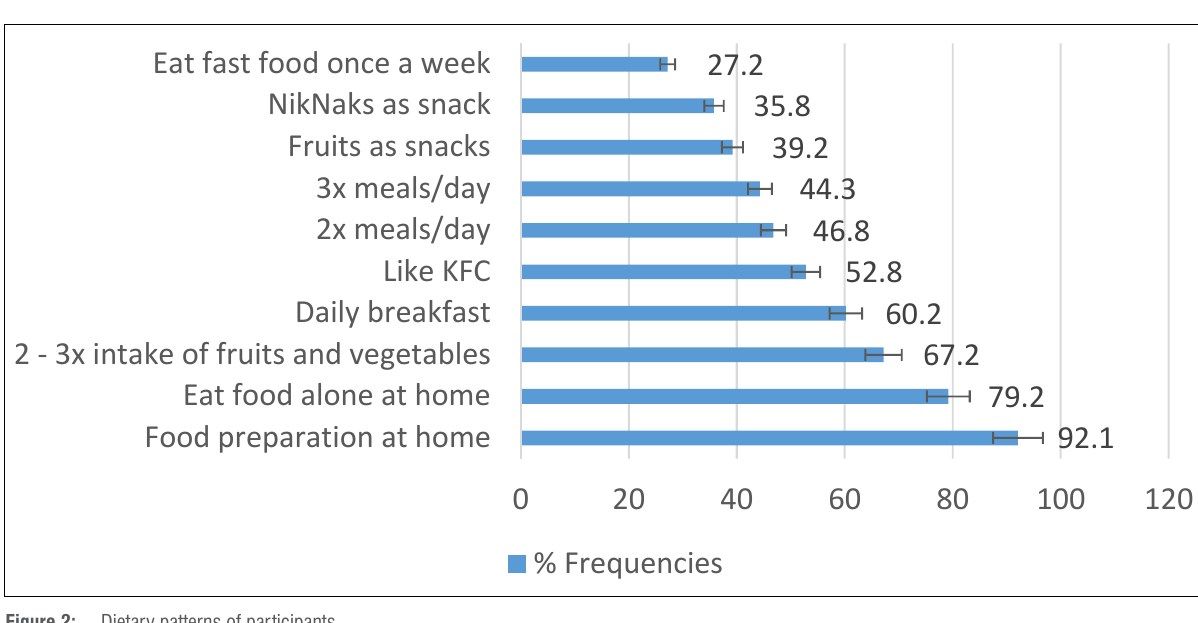
Figure 2: Dietary patterns of participants. Table 2: Food groups consumed by >50% of households by dietary diversity category Low dietary